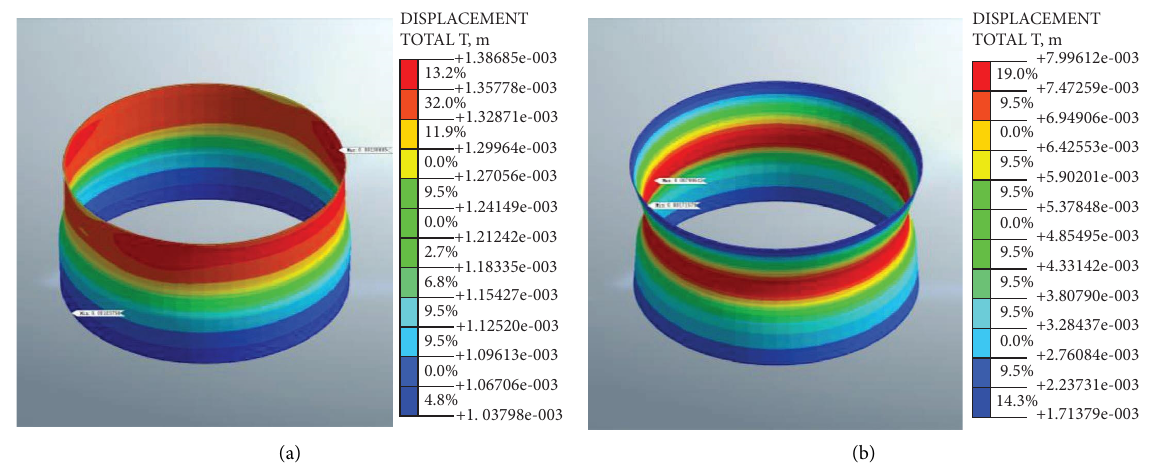
Figure 20: Working condition 2 wall deformation (a) without pore water pressure and (b) with pore water pressure applied.